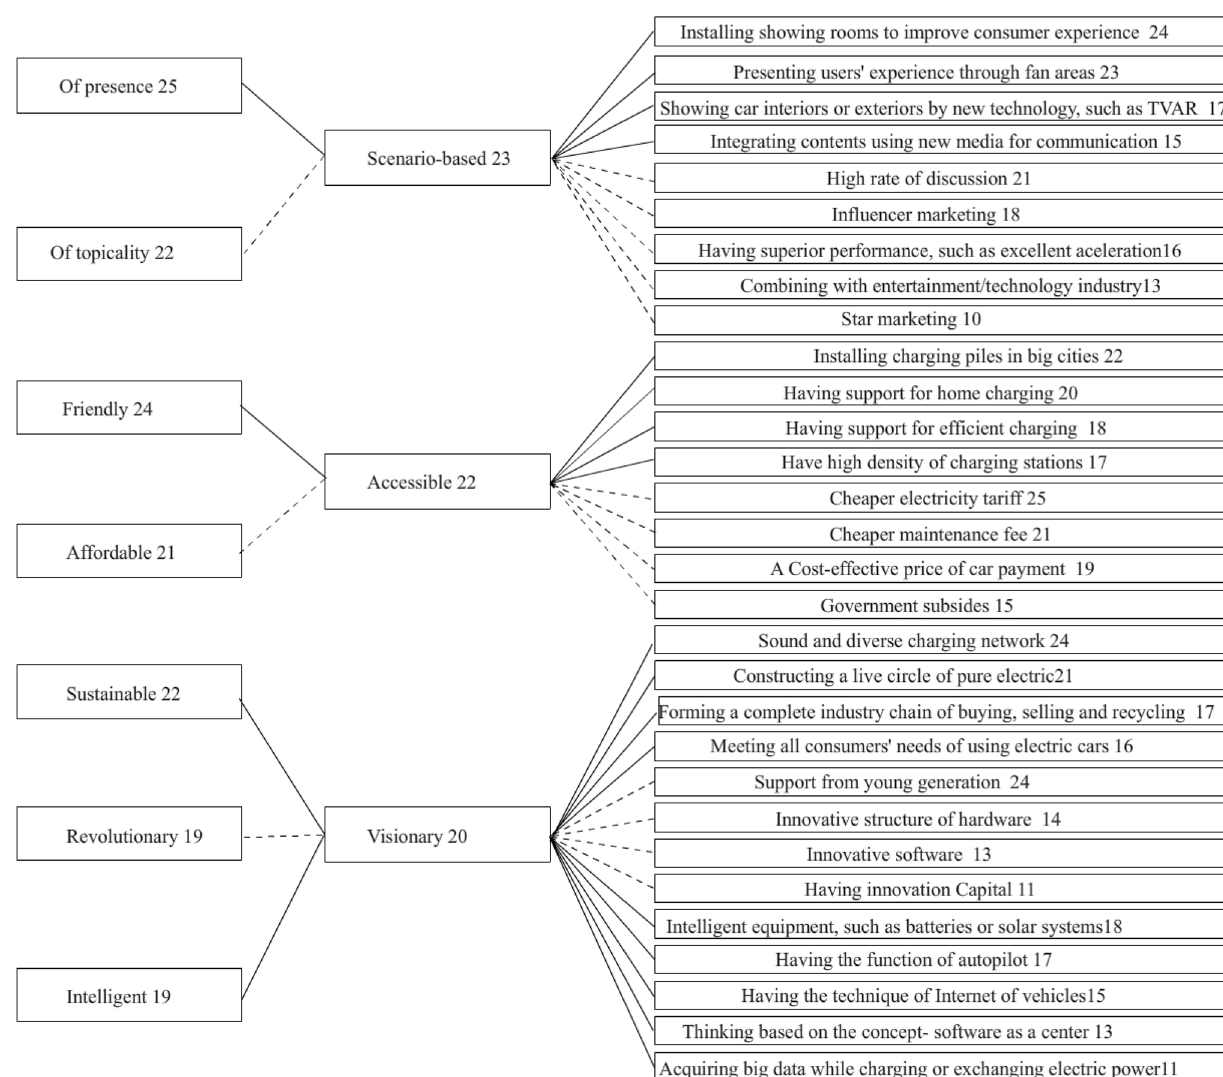
Fig. 2 The hierarchical diagram of experts’ preferences for electric car marketing, determined by EGM